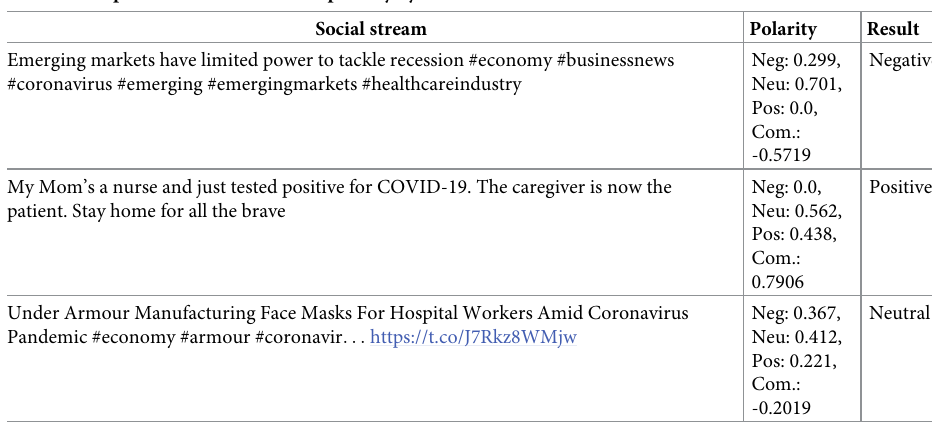
Table 4. Sample tweets with sentiment polarity by